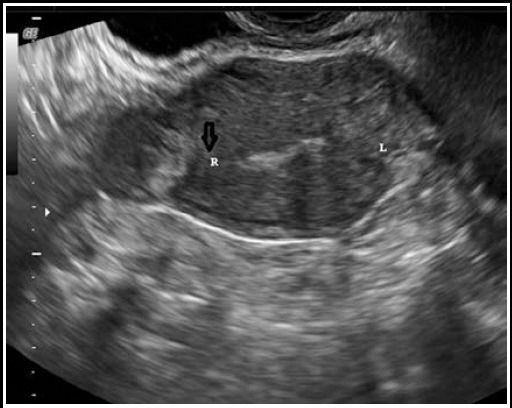
Coronal view of the fundus of the uterus on transvaginal ultrasound showed a mass measuring 2 cm in the right uterine horn and the interstitial line sign (black arrow).